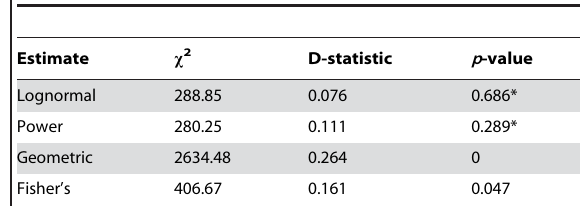
Table 3. Evaluation of the fit of different distributions to TRFLP data from the soil community.